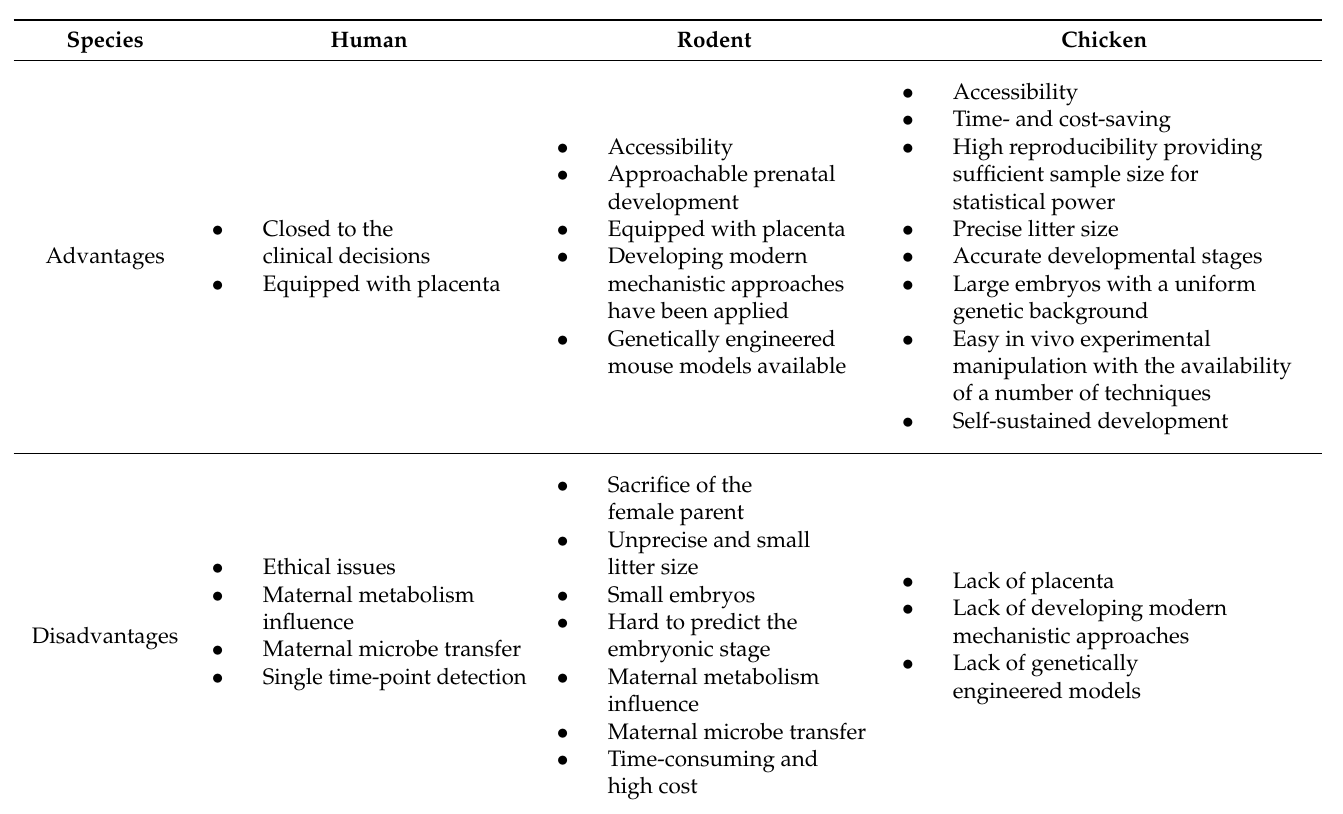
Figure 2. Schematic diagram summarizing the prenatal and postnatal events affecting the gut micro- biome during offspring development. The maternal–fetal microbe transfer during 40-week pregnancy, natural labor, and breast-feeding constitutes the initial microbiome in offspring. Multiple environmental factors, including food intake, disease, and drug administration, during postnatal life alter the gut microbiota composition and diversity. Moreover, the disease state and medical history affect the neu- roendocrine, reciprocally interacting with gut microbiota via the microbiota–gut–brain axis. The color represents the time sequence of the events that occur during the lifespan. Table 1. A comparative summary among human, rodent, and chicken models in investigating ontogenetic mental health